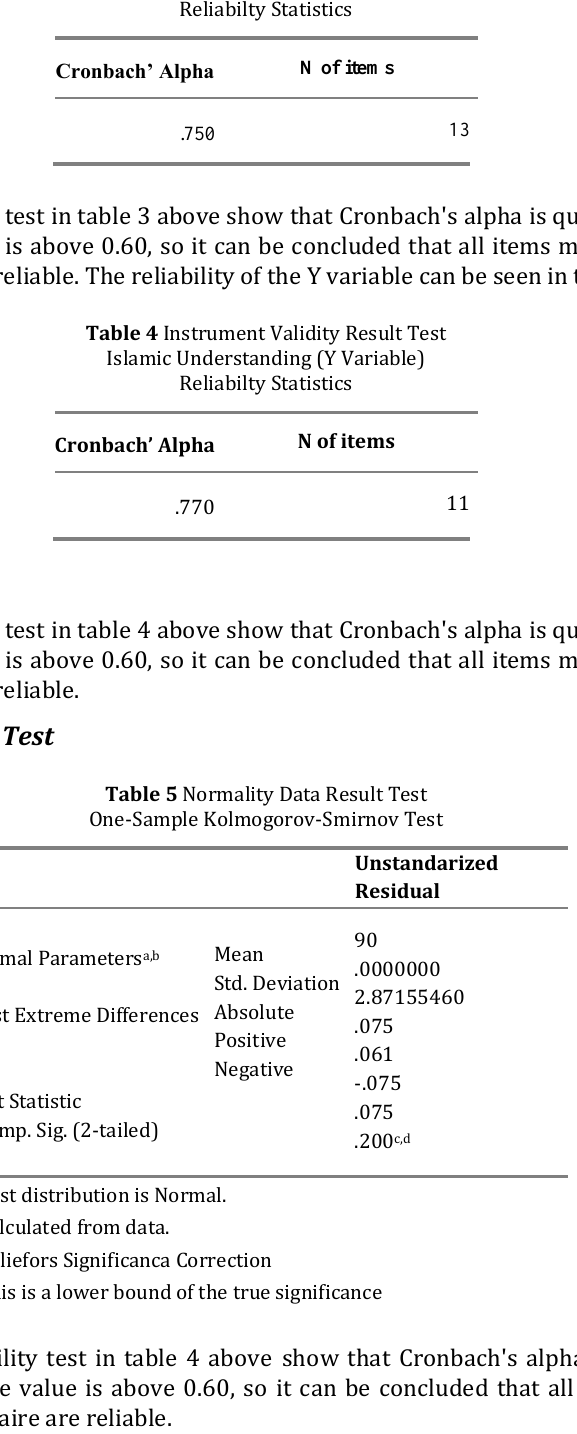
Table 3 Instrument Validity Result Test